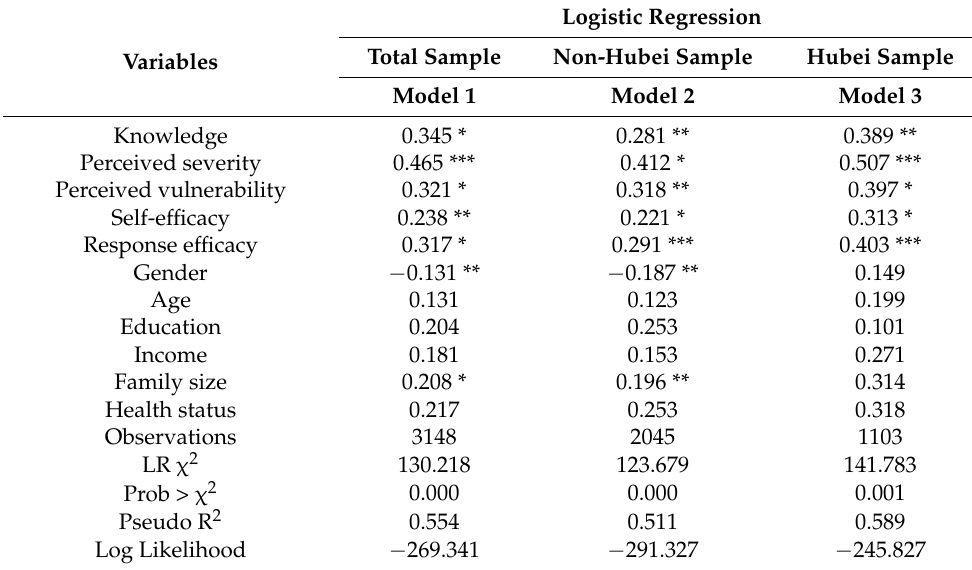
Table 7. Determinants of residents’ WTP.